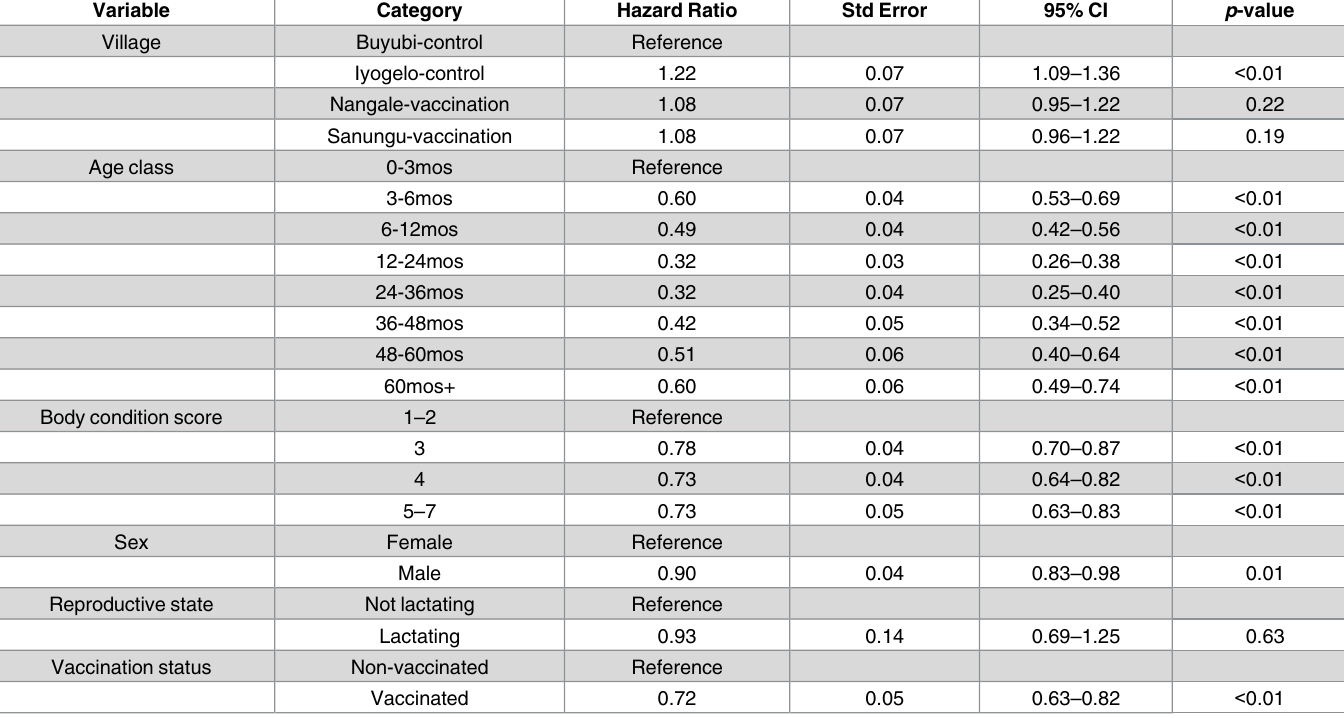
Table 2. Hazard ratios, standard errors, 95% confidence intervals and p -value results of multivariable adjusted Cox proportional hazards model comparing the risk of death across villages, age categories, BCS, sex, reproduction, and vaccination status.